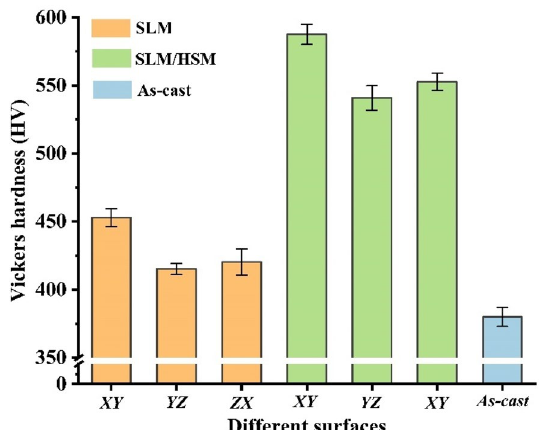
Figure 13 Hardness of the In738LC samples made by different processes